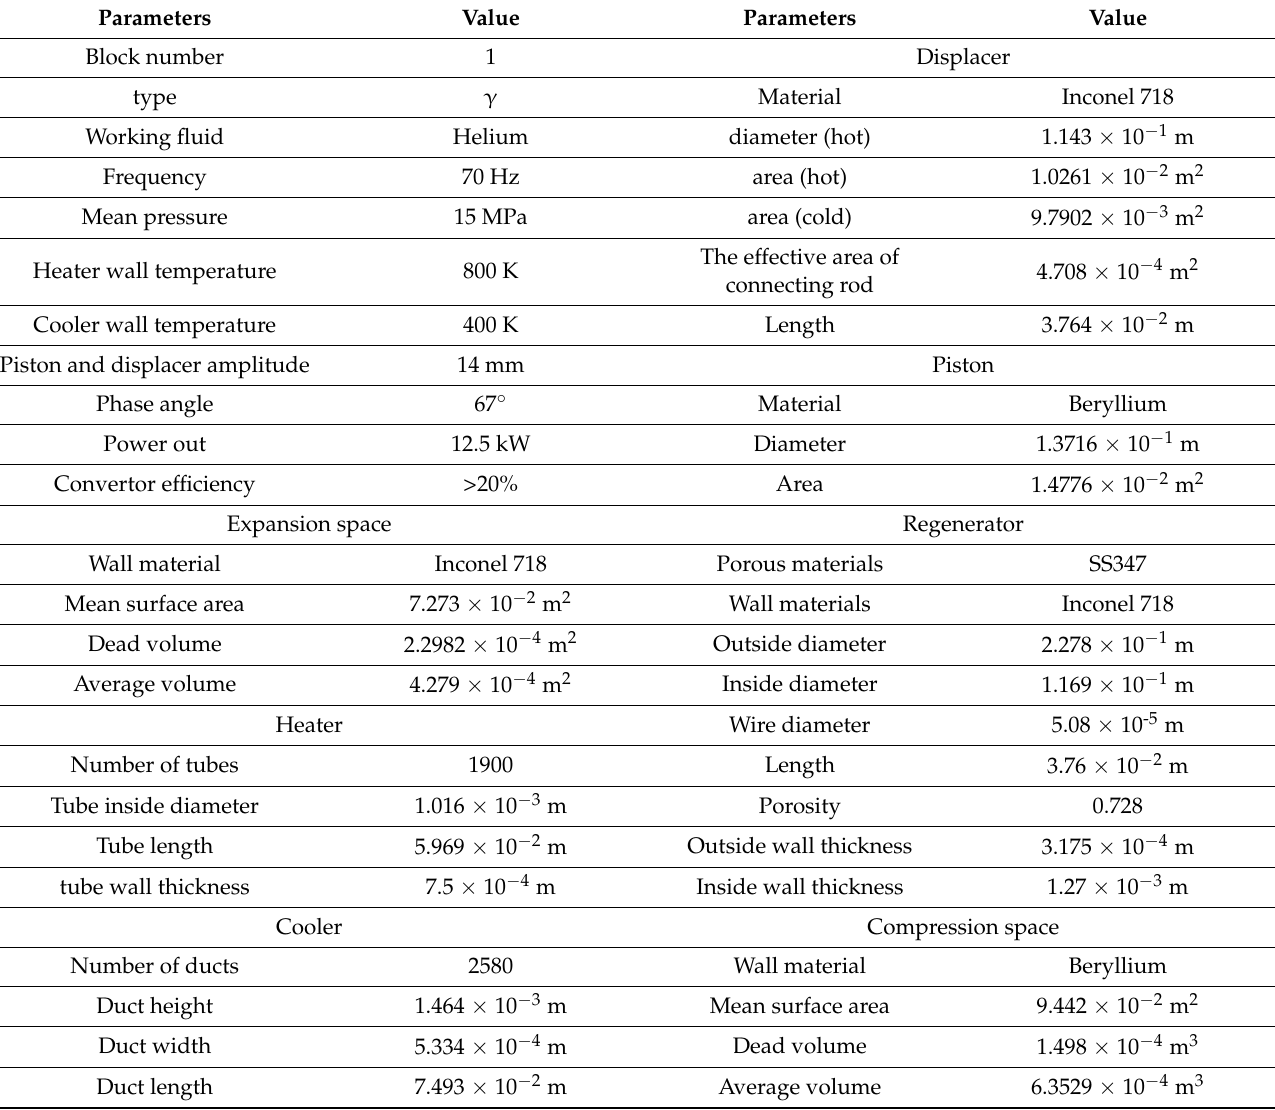
Table 3. The design parameters of